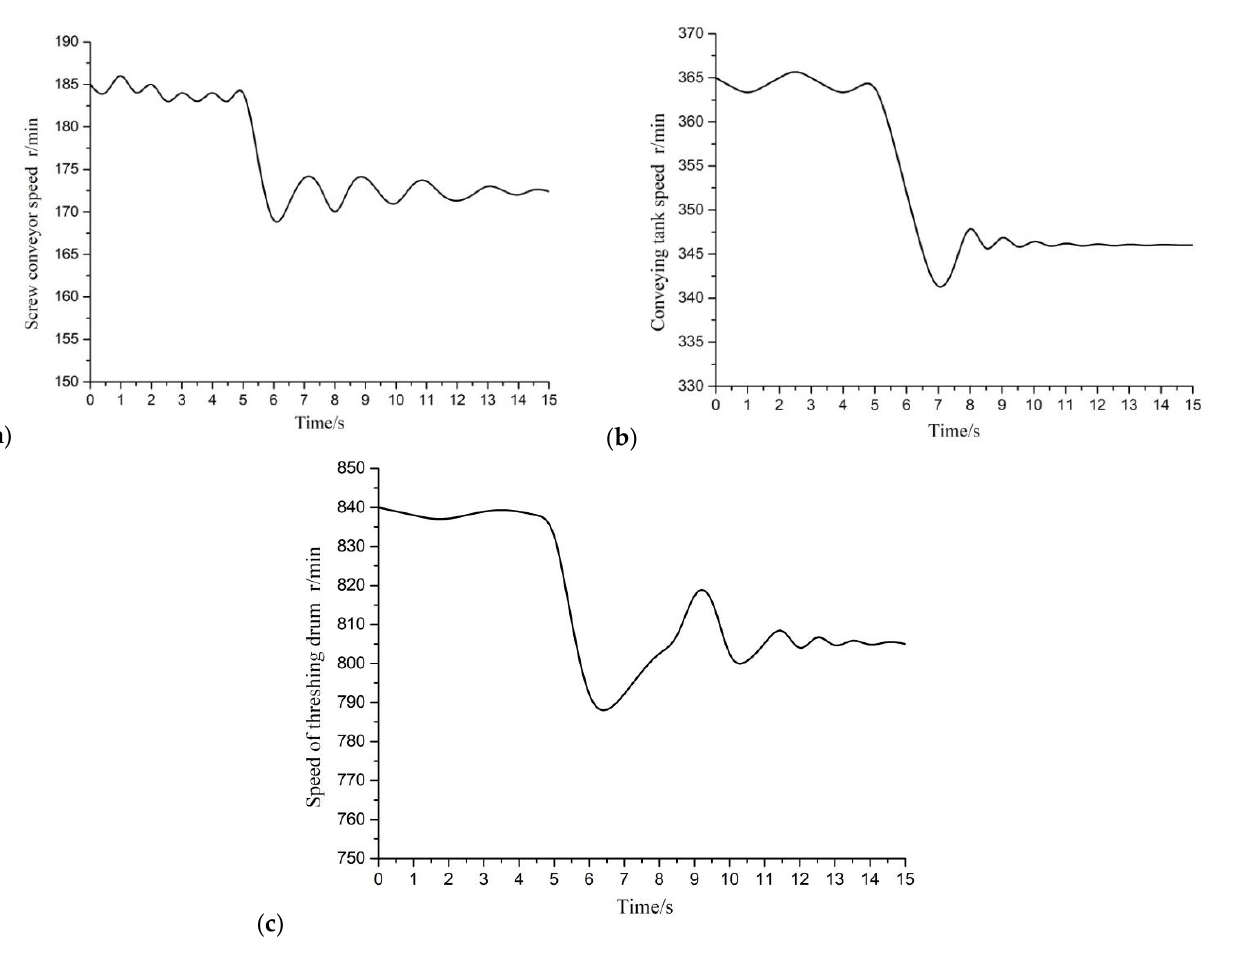
Figure 12. The relationship curve of walking speed and time.